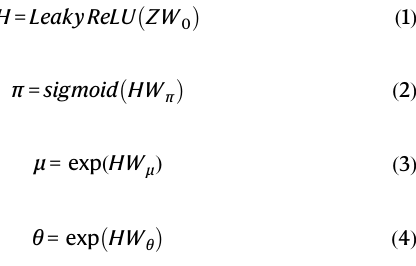
Fig. 4 | Prediction of amyloid plaque size from the joint latent representation results in the identi fi cation of cell types and chromatin features that are pre- dictiveofplaquenearcells.a Anexampleofoverlaidchromatin(red)andamyloid plaque (green) channels from the 13-months AD sample with 10021 cells. b Schematicofourregressionmodelthatpredictsplaquesizefromthejointlatent representation of gene expression, cell adjacencies, and chromatin images. c Regression gradient (blue) projected to the input chromatin image (red). The analysisusesthetwoADmousesampleswithatleast7257cellseach. d Distribution of regression gradients within single cells in each cell type in cluster 3 of AD sam- ples.* p -value<0.05for8-monthvs13-monthsamples.Cellsarefromtwomicewith at least 7257 cells each. Bounds of boxes indicate quartiles. Whiskers indicate extrema. Two-sided T -tests are performed and raw p -values are 0.2446 (Astro), 0.002677 (Endo), 0.04300 (Ex), 0.2872 (Inhi), 0.002549 (Micro), 0.6968 (OPC), 0.01780 (Oligo), 0.1019 (SMC). e Histogram of chromatin pixel intensities of